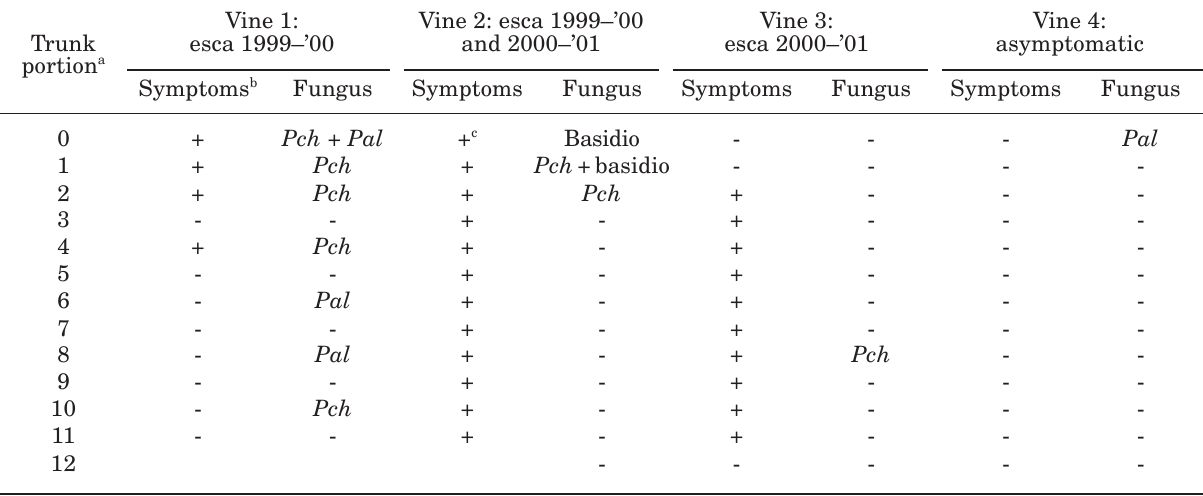
Table 3. Internal symptoms and esca-associated fungi ( Phaeomoniella chlamydospora, Pch ; Phaeoacremonium aleo- philum, Pal ; white heart rot fungus, basidio) found in the trunks of 4-year-old own-rooted Cabernet Sauvignon vines from site 2, Wentworth, New South Wales,